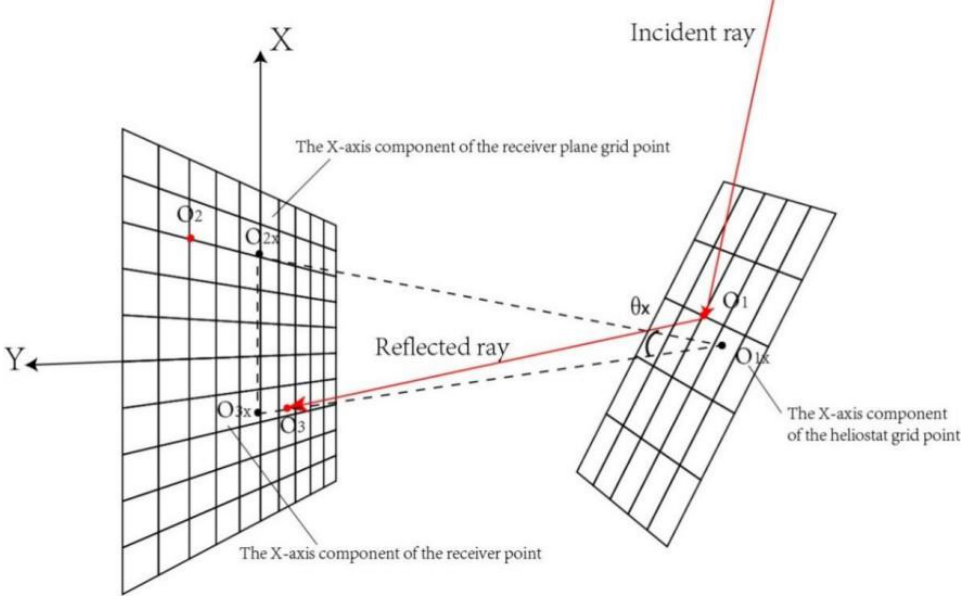
Figure A2. The included angle between the reflected ray of each grid and O 1 O 2 in the X-direction under the elliptic Gaussian